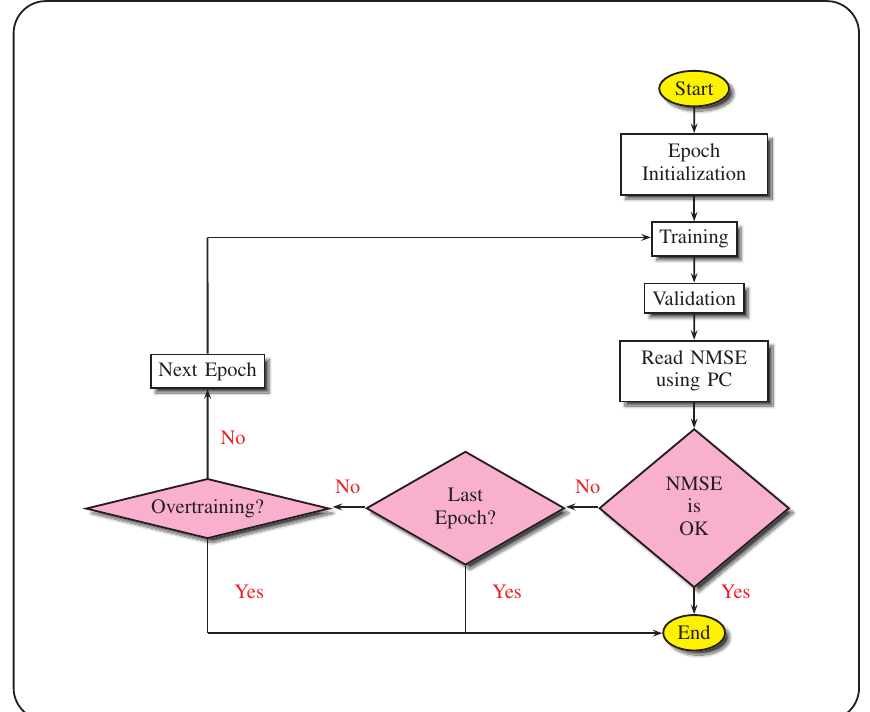
Figure 15. Training and validation